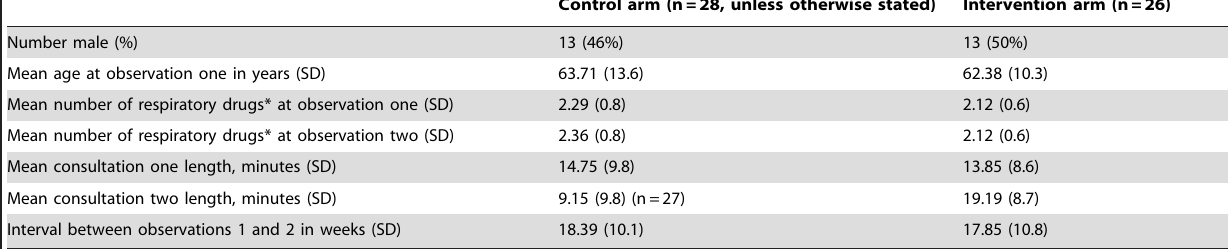
Table 2. Participant and consultation